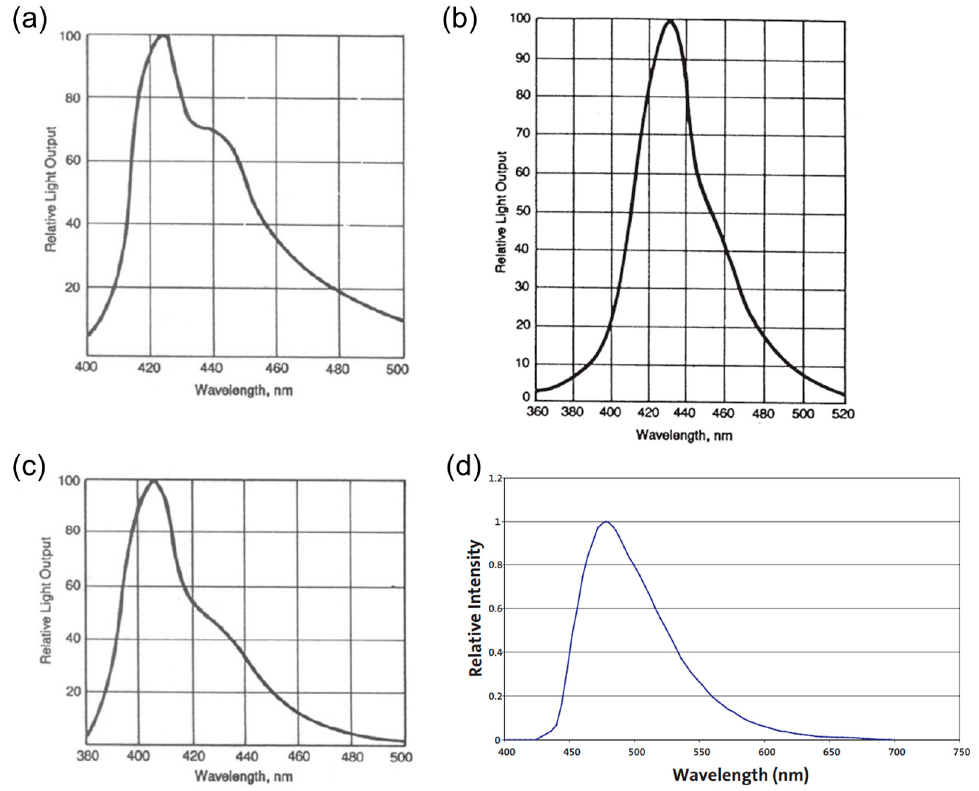
Figure 4. Emission spectrum with wavelength of plastic scintillation ( a ) BC-400, ( b ) BC-404, ( c ) BC-408, and ( d ) BC-428 [67].